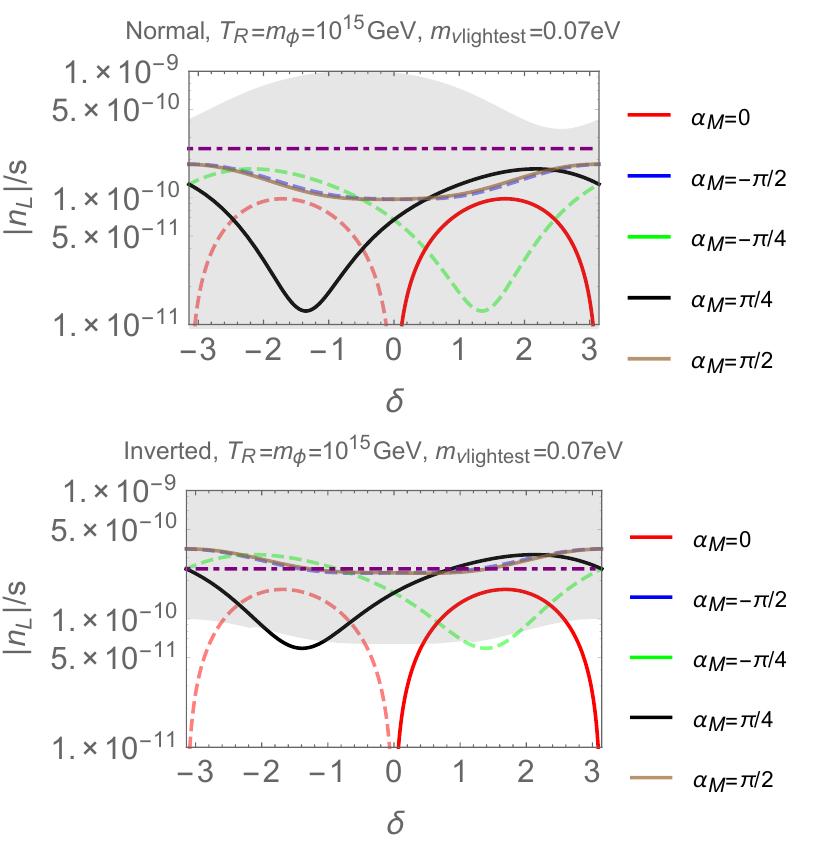
Figure 8 . Same as (cid:12)gure 7, but m (cid:23) lightest = 0 : 07 eV is taken with (cid:11) M 2 = 0. The uncertainty for (cid:11) M = (cid:25)= 2 case is shown in the gray bands.